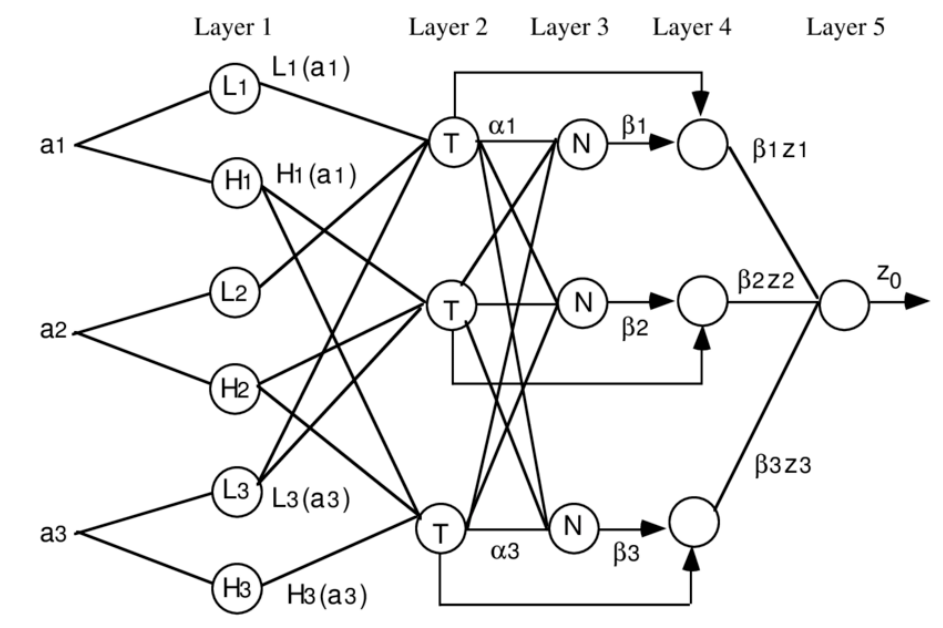
Figure 4. ANFIS model and its nodes.